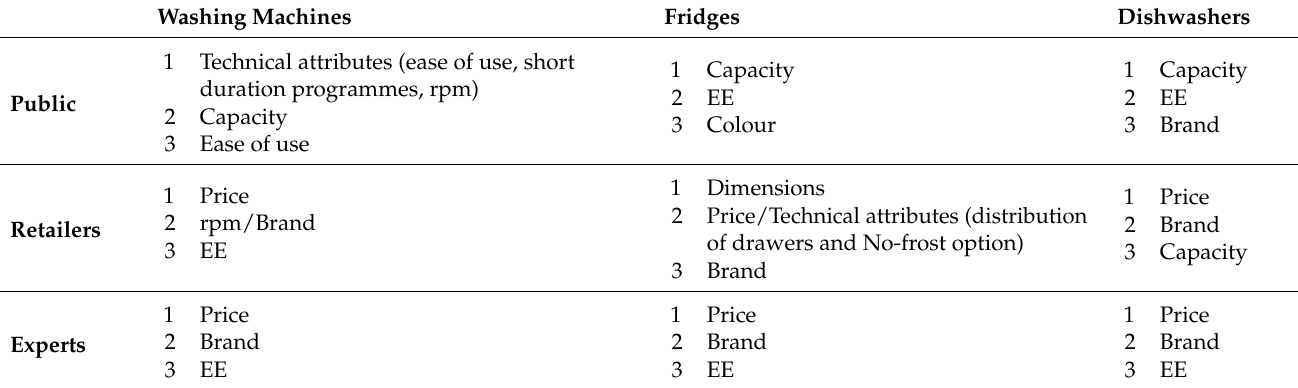
Table A4. Top three attributes mentioned per product category and group